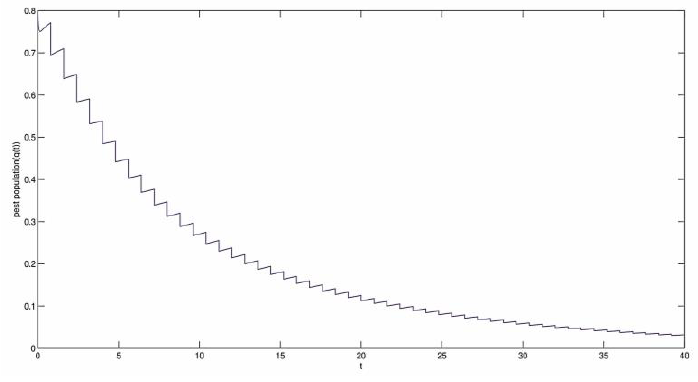
Figure 10. Existence of the pest population (𝑞(𝑡)) for 𝜇